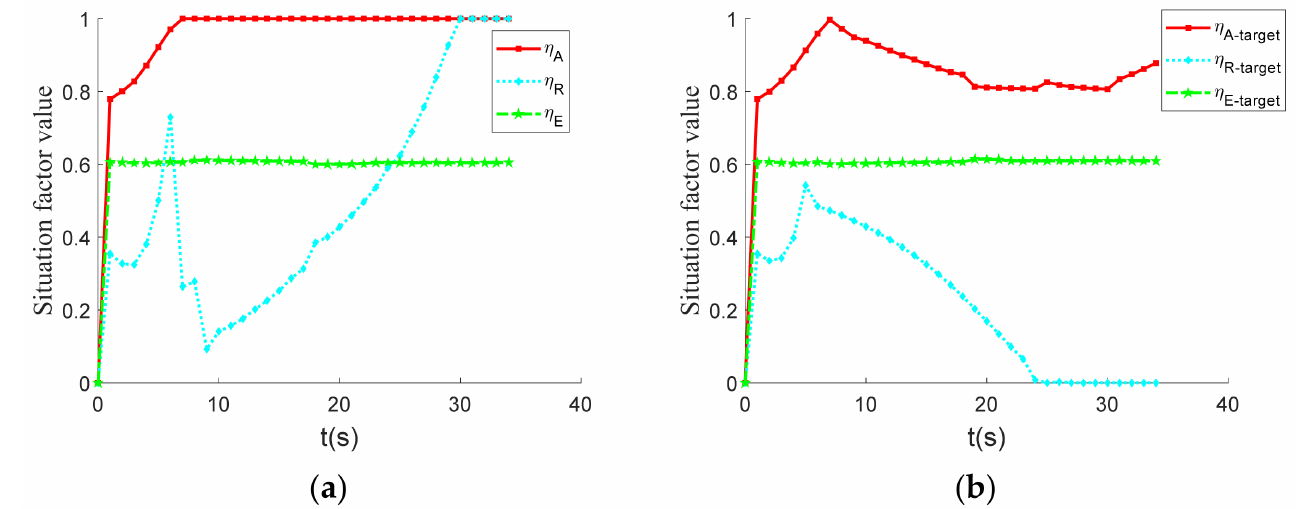
Figure 9. Maneuver situation factor change curve. ( a ) UCAV; ( b )